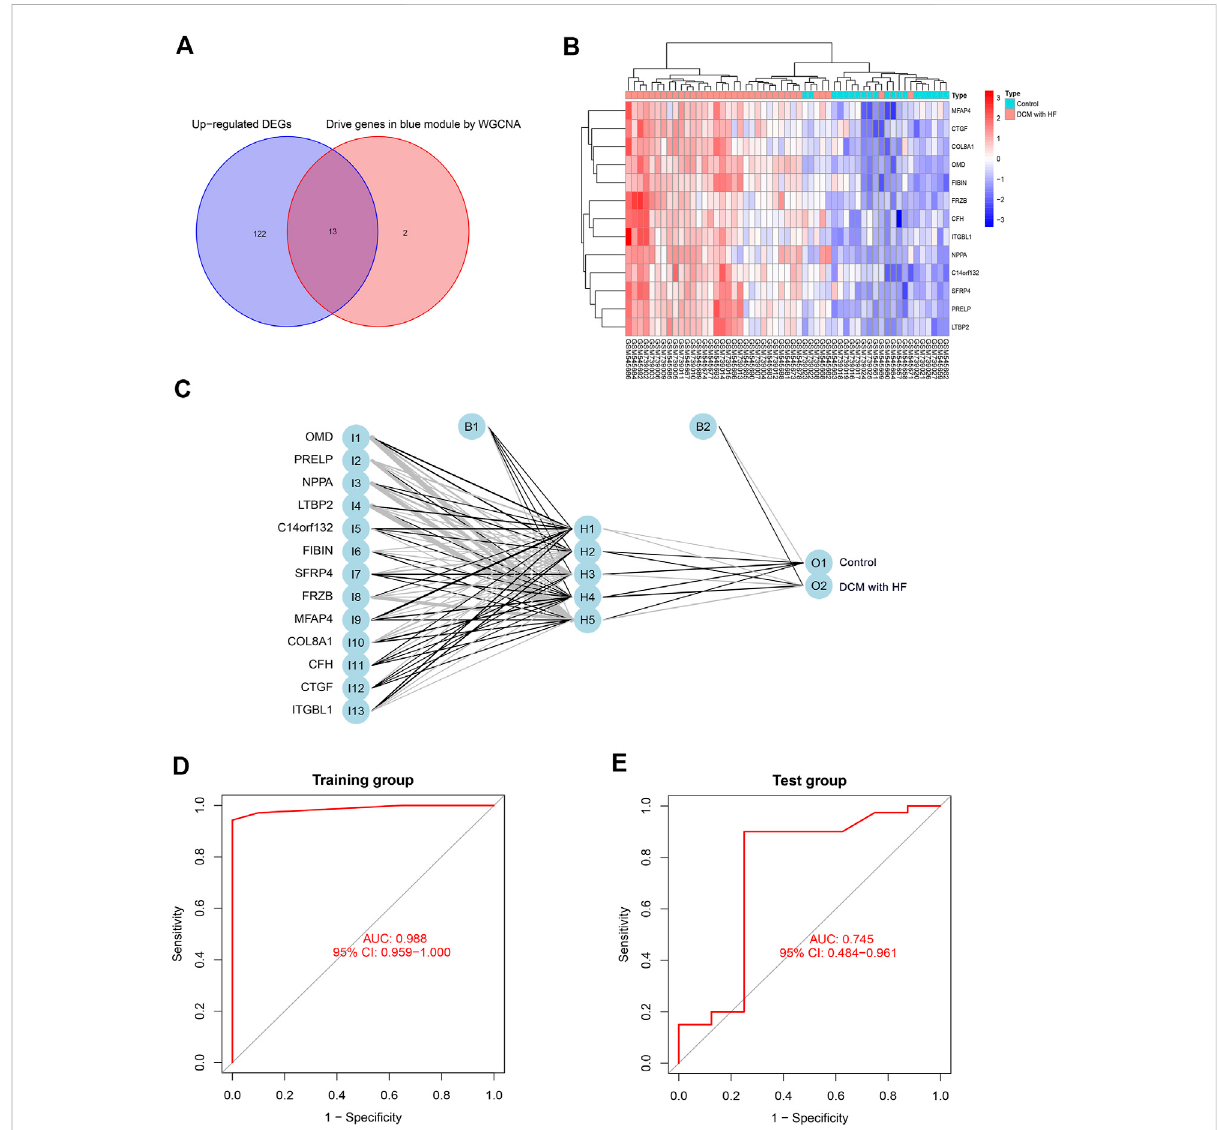
FIGURE 5 ConstructionandvalidationofBPNNon13featuregenes. (A) Theintersectionof135up-regulatedgenesand15drivergenesinthebluemodule asfeaturegenes. (B) Expression heatmapof13featuregenesincontrol andDCMwith HFgroups. (C) BPNNconstructedwith 13neuronsintheinput layer, fi ve neurons inthe hidden layer, and two neurons in the output layer. ROC curve for evaluating classi fi cation accuracy in the training group (D) and test group (E) . I, input layer; H, hidden layer; O, output layer; B,